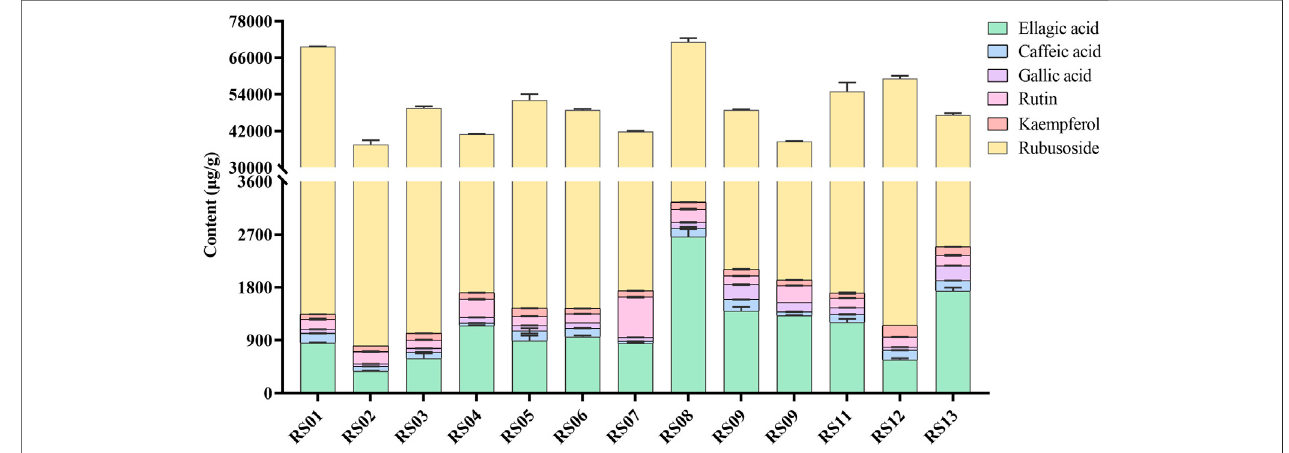
FIGURE 5 | The content of ellagic acid, caffeic acid, gallic acid, rutin, kaempferol, and rubusoside in 13 batches of Rubus chingii var. suavissimus samples from markets.